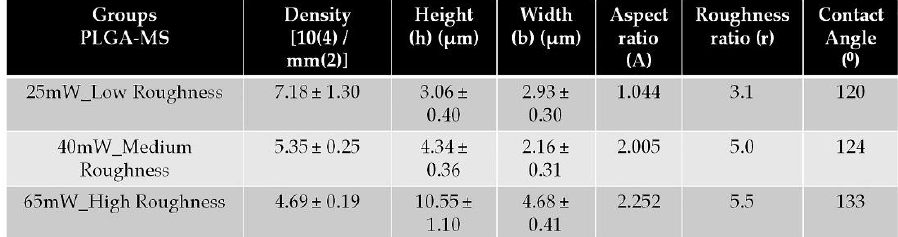
Figure 3. Scanning electron microscopy (SEM) images (tilted ( a – c ) and top ( d – f ) view) of PLGA-MS replicas of the three different topographies (25 mW_Low Roughness, 40 mW_Medium Roughness, and 65 mW_High Roughness). The white arrows represent the spikes’ direction. Under the images, directionality histograms and tables with statistics are presented, which were generated using the Fiji ImageJ plug-in “Directionality” [43]. Above the histogram, the plug-in generates statistics for the highest peak found. The highest peak is fitted by a Gaussian function, taking into account the periodic nature of the histogram. In the tables, the “Direction ( ◦ )” column reports the center of the Gaussian; the “Dispersion ( ◦ )” column reports the standard deviation of the Gaussian; the “Amount” column is the sum of the histogram from center-std to center+std, divided by the total sum of the histogram; the “Goodness” column reports the goodness of the fit, where 1 is good, 0 is bad. Measurements of the geometrical parameters of the surface of the PLGA-MS (10%) replicas at the three different topographies (25 mW_Low Roughness, 40 mW_Medium Roughness, and 65 mW_High Roughness) on the SEM images (top and tilted view) of the PLGA-MS replicas were processed using an image-processing algorithm (Fiji ImageJ) to determine the topological characteristics of the MSs. Measurements include the height (h), width (d), aspect ratio (A), and roughness ratio (r) from the top (highest magnification) and tilted-view SEM images. The aspect ratio was calculated by dividing the height by the radius of the spike’s base. For the PLGA-MS replicas, a surface plot of each image was produced by Fiji ImageJ, and the height and spike’s base were measured. From each image, at least 10 measurements were performed. The roughness ratio, r, was calculated by dividing the actual, unfolded, surface area of spikes by the total irradiated area (r = 1 + 2h/b, where b is the width of spikes). The mean value was calculated from four individual surfaces in each case. Measurements of the contact angles were performed with the use of a